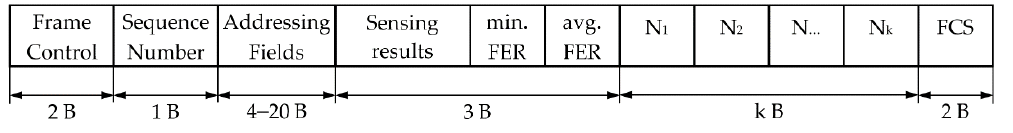
Figure 8. Hello frame format.